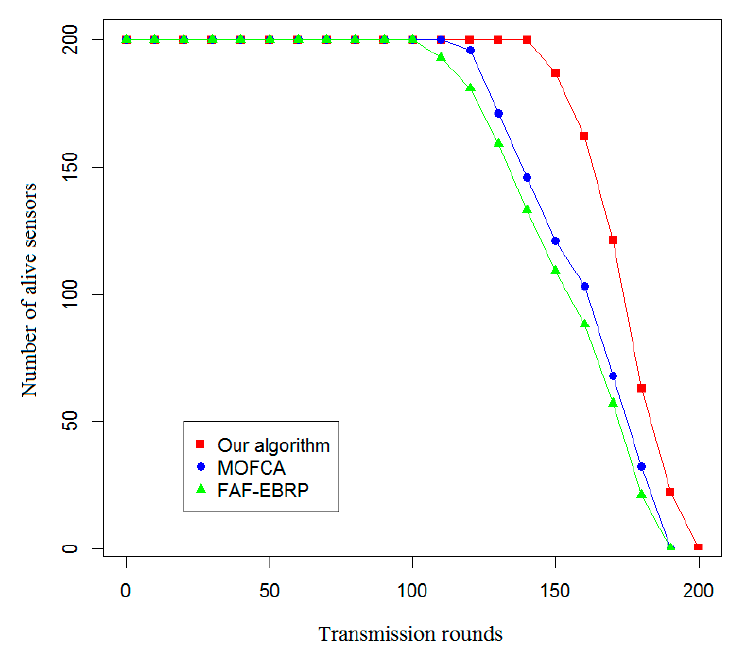
Figure 7. Comparison of the effective life cycle of the system. Sensors 2020 , 20 , x FOR PEER REVIEW